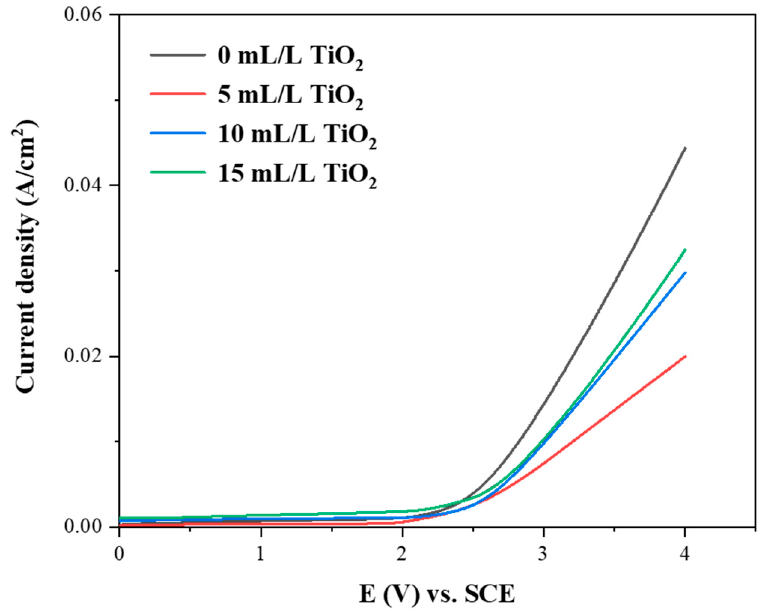
Figure 5. LSV results of electrodeposited Ti/SnO 2 -Sb 2 O x and Ti/SnO 2 -Sb 2 O x -TiO 2